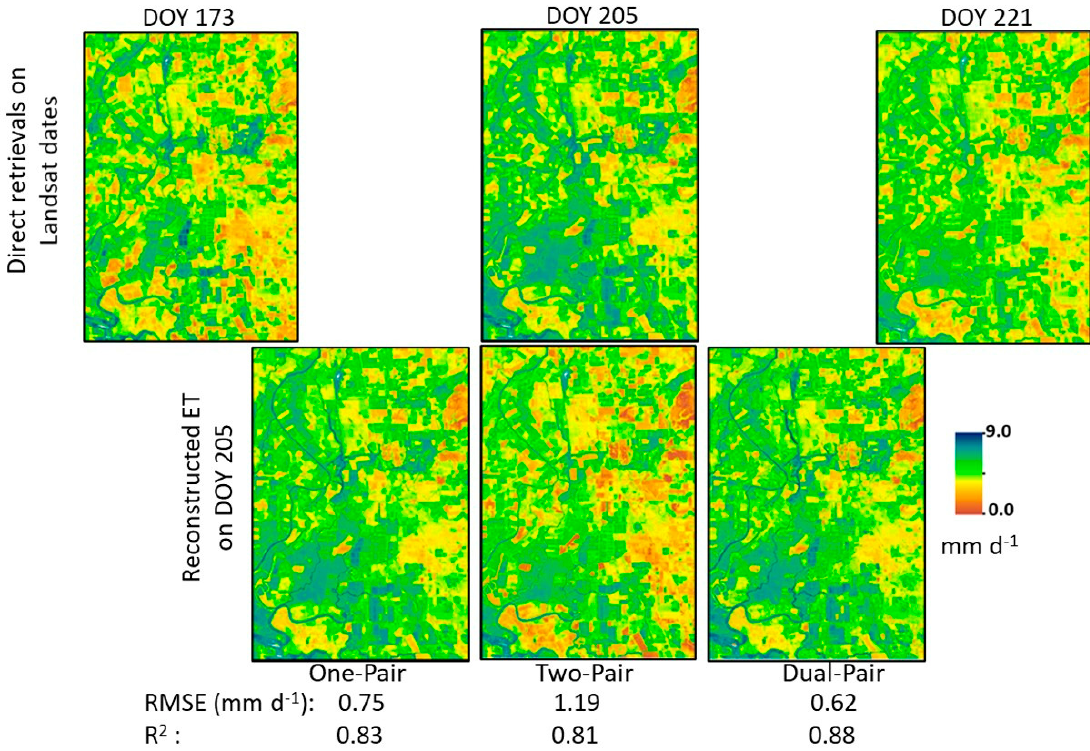
Figure 4. Reproduced Landsat-scale ET on DOY 2014205 using different STARFM methods comparing with direct retrievals of Landsat ET.